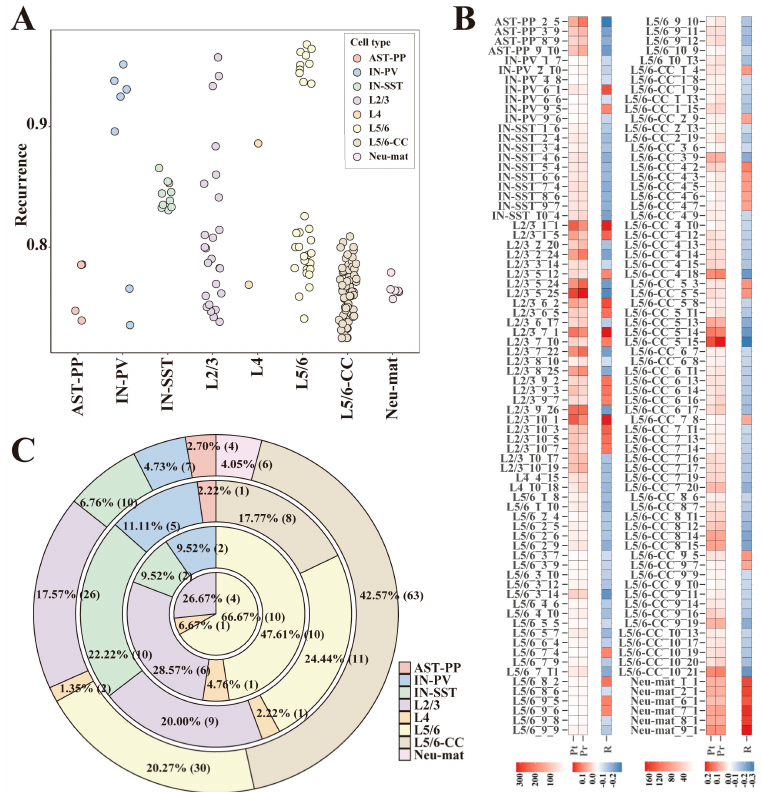
Figure 3. Gene modules with high recurrent rates. ( A ) Scatter plots of reproducible rates of the 148 gene modules with a reproducible rate greater than 70%. ( B ) The heat map of ASD-correlation tests for the 148 gene modules: the columns “Pt” and “Pr” show the − log 10 (adjusted p -value) of the two significance tests: (1) the significance test of the difference in module activation coefficients between ASD/control groups; and (2) correlations between the module’s activation coefficient and the cells’ ASD/control label. The “R” column displays Spearman correlation coefficients for the second test mentioned above. ( C ) The ring-shaped percentage graph of the number of gene modules when the recurrence threshold was 70%, 75%, 80%, and 85% (from the outside to the inside). Note: gene module indexes are composed of: the module’s cell type, the sequence number of the data partition, and the sequence number of the module in the data